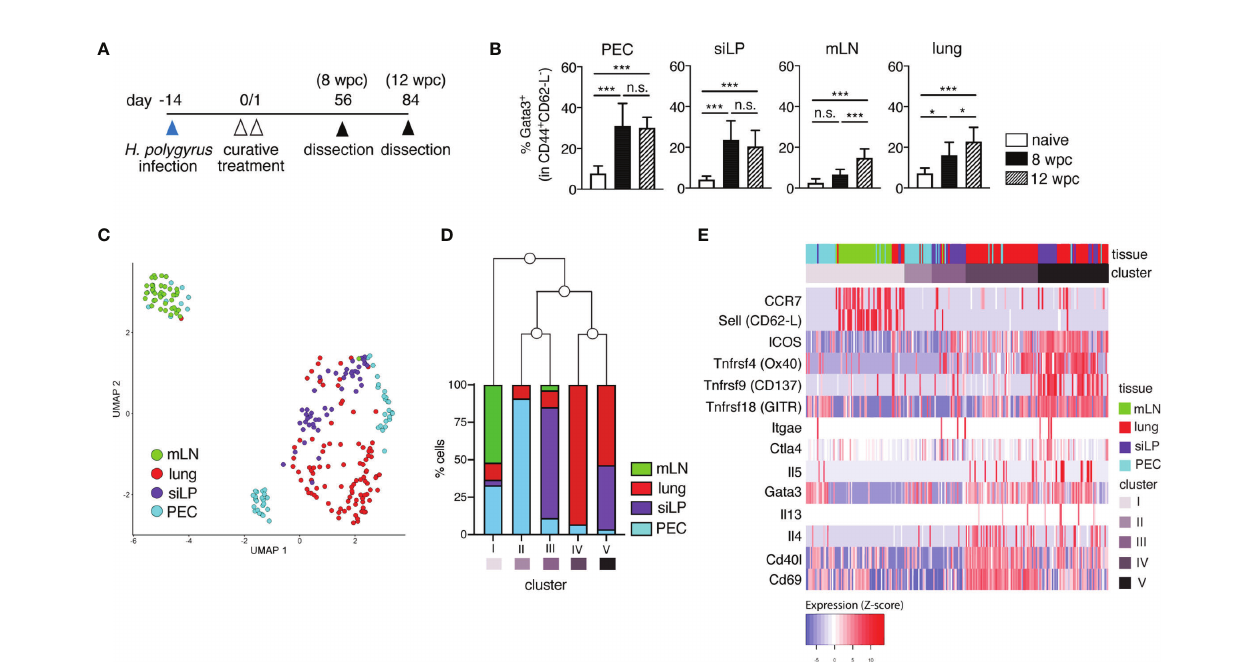
FIGURE 1 | Memory T cells persist long-term and display distinct transcriptional pro fi les in lymphoid versus non-lymphoid tissues following primary nematode infection. (A) Experimental set-up. Mice were infected via oral inoculation with 225 infective L3 H. polygyrus larvae and were cured of infection 14 days later via oral administration of 2 mg/mouse pyrantel pamoate anthelminthic on two consecutive days. The mice were then allowed to rest and were sacri fi ced 8- and 12-weeks post-cure. (B) Frequencies of memory Th2 cells in peritoneal cavity (PEC), small intestinal lamina propria (siLP), mesenteric lymph nodes (mLN) and lung of naïve and cured mice. (C) UMAP of single-cell RNA-seq data of sorted CD4 + T cells from PEC, siLP, mLN and lungs of mice sacri fi ced at 8 weeks post-cure. (D) Bar graph illustrating the fi ve different clusters de fi ned by hierarchical clustering of hyper-variable expressed genes in the single cell transcriptomes and the frequencies of cells from each tissue contributing to each cluster. (E) Heatmap representation of selected marker genes. The order of the columns derived from the hierarchical clustering of the hyper-variable expressed genes and the order of the rows was prede fi ned by the authors. Different colours correspond to the scaled expression (Z- score) of each gene in each cell. The data in (B) are pooled from two independent experiments with n = 3-5 mice per group. Statistical analysis in (B) was done using one-way ANOVA combined with Tukey ’ s multiple comparison test. * p < 0.05, *** p < 0.001, n.s., not signi fi cant. For sorting of CD4 + T cells for RNA-seq analysis, two mice were infected and cured as described in (A) . 8 weeks post-cure the mice were killed for single cell